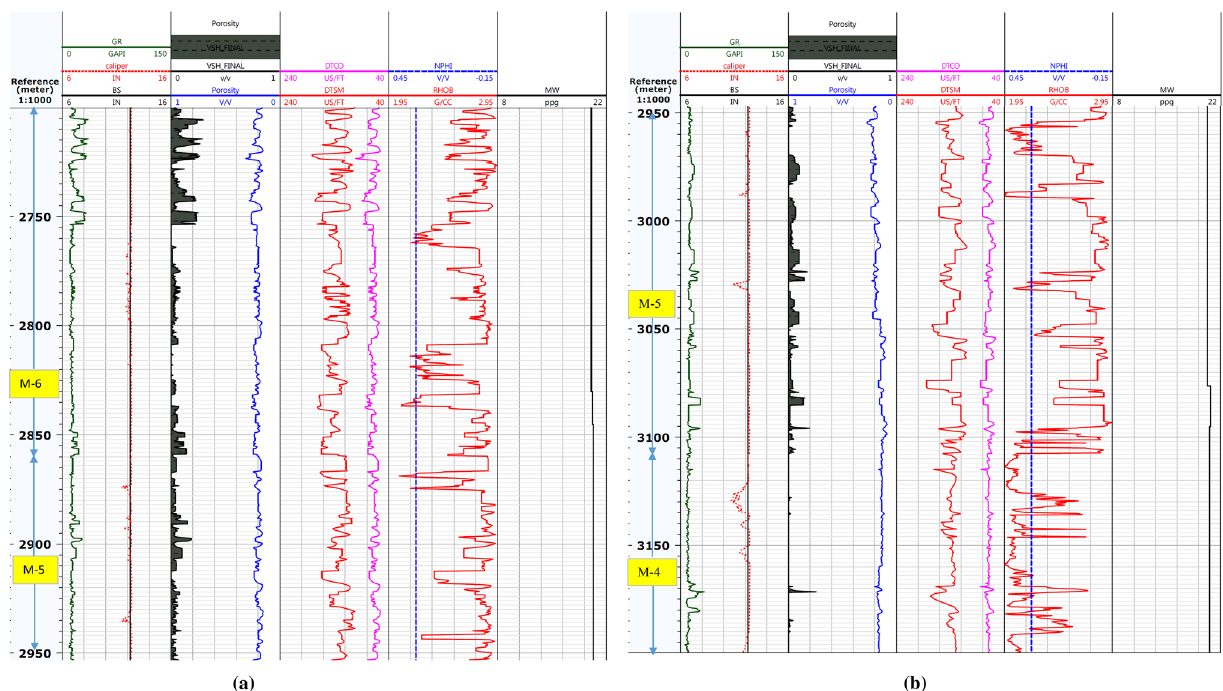
Fig. 7 a Interpreted petrophysical data and mud weight required for MEM construction in well Z26 (2700–2950 m). The depth intervals of the members of Gachsaran formation have been indicated. b Inter-